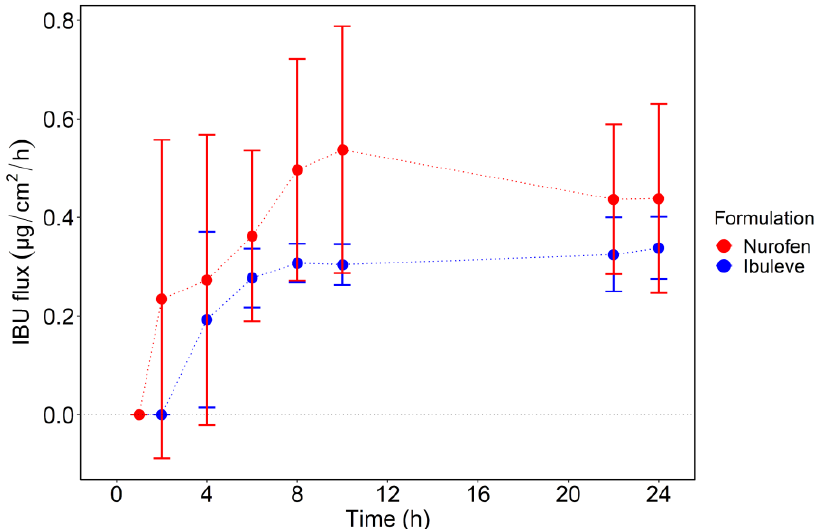
Figure 2. Estimated flux profiles of IBU (μg/cm 2 /h) through human epidermis following application of the commercially available formulations, Ibuleve and Nurofen ( n = 5; mean ± SD).